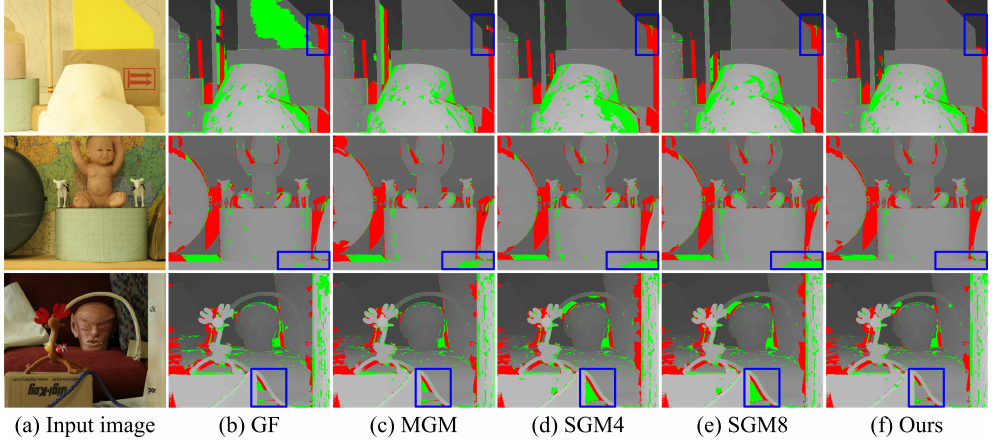
Figure 5. Examples of disparity images for MGM, SGM and our method on Mibblebury dataset [9]. SGM4 and SGM8 corresponds to performing optimization along four and eight scan lines for SGM. Red and green pixels are mismatched pixels in occluded and non-occluded regions,